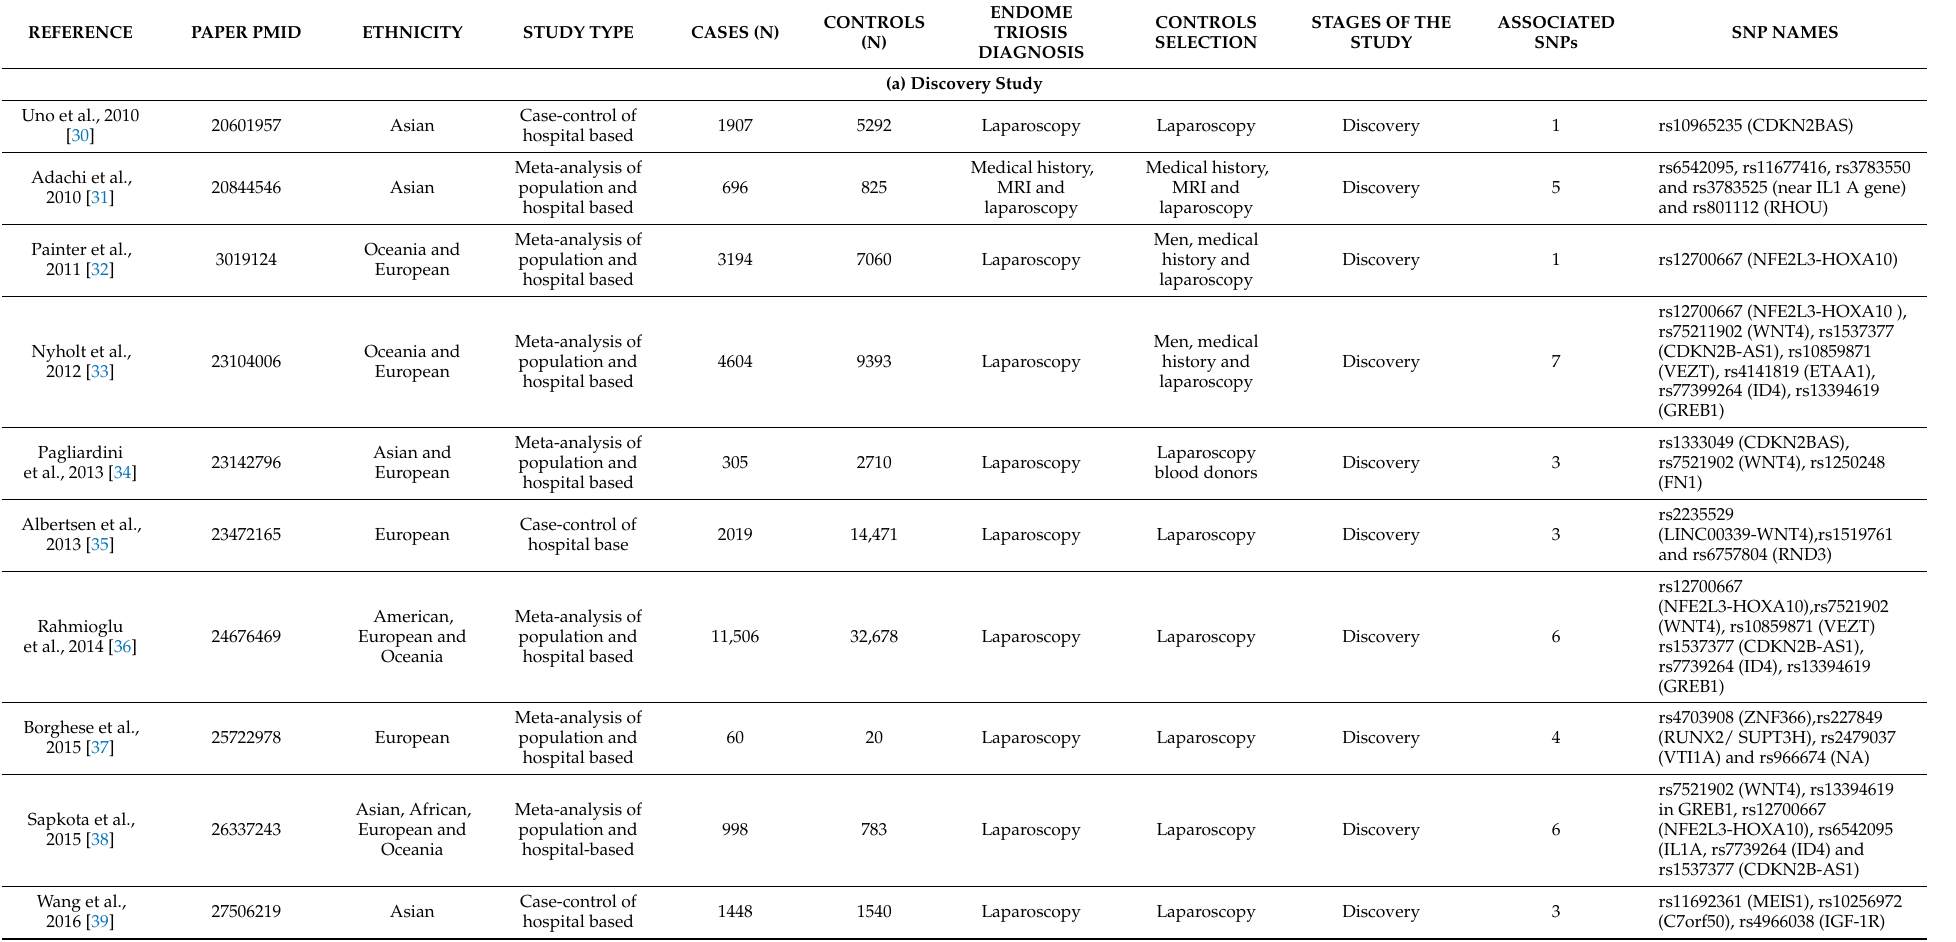
Table 1. List of Genome Wide Association